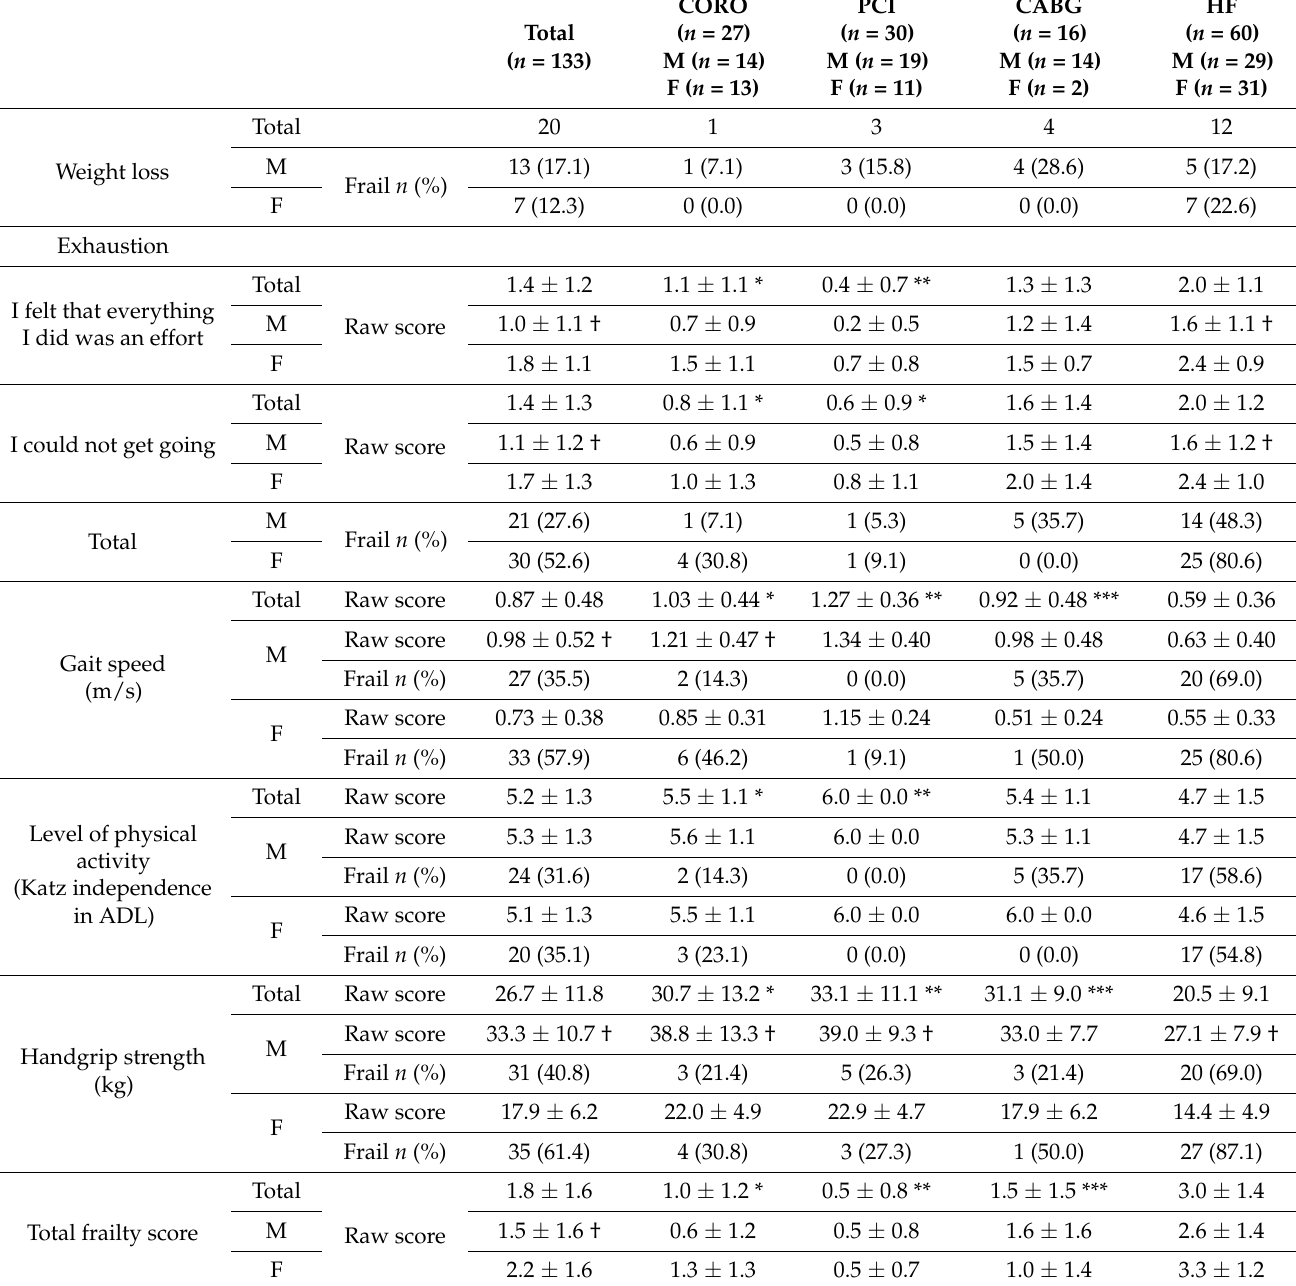
Table 2. Number of frail subjects according to CVD and sex and analysis of the frailty component scores based on the Fried frailty assessment